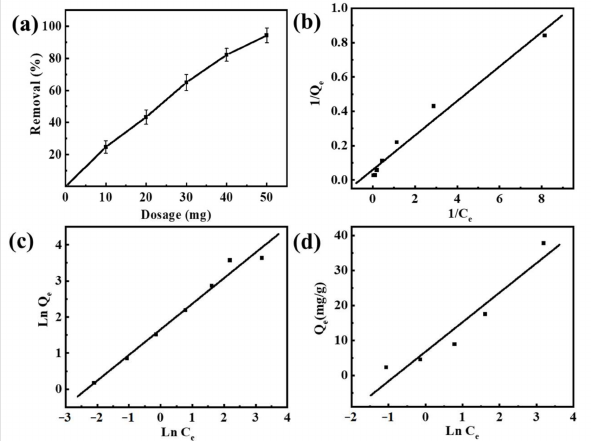
Figure 6. ( a ) Effect of MPBN dosage on the removal rate of cesium ions (C 0 = 40 mg/L; T = 293